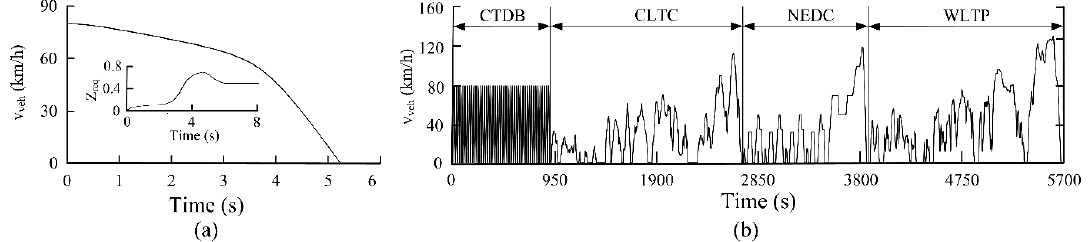
Figure 9. Schematic diagram of the driving cycle in simulation: ( a ) the customized typical deceleration braking (CTDB) and ( b ) comprehensive driving cycle.